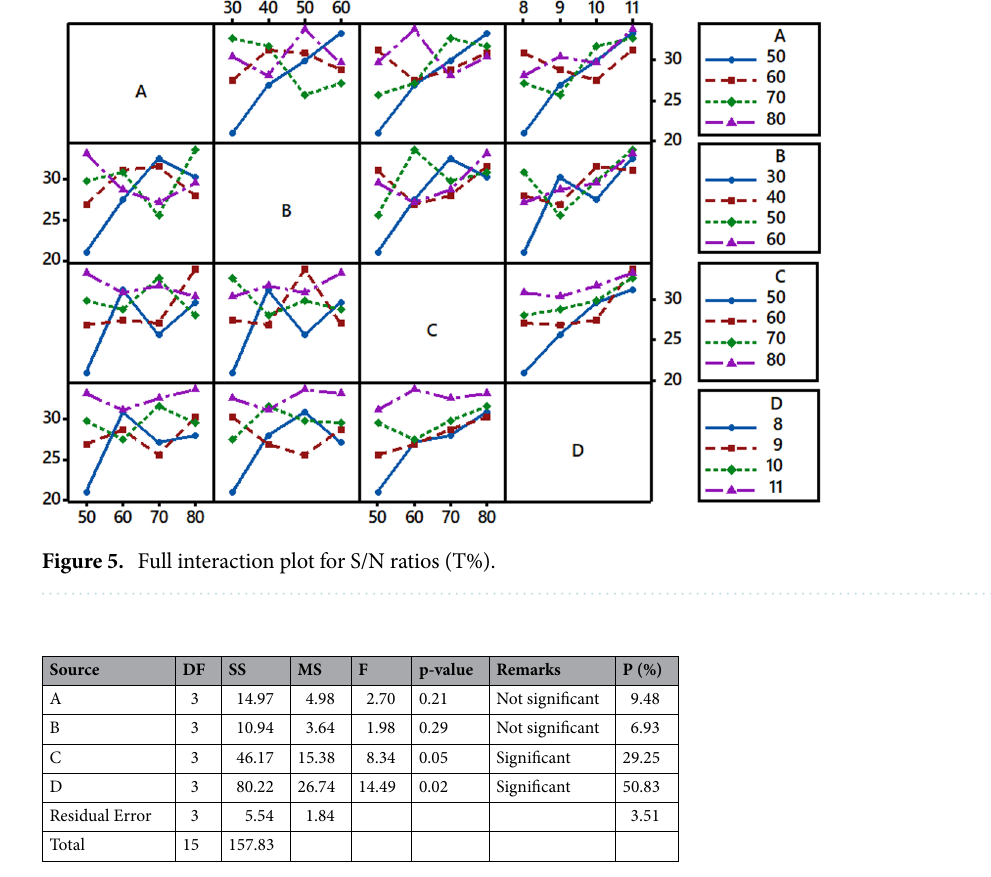
Table 9. ANOVA for S/N ratios of total dye fixation efficiency (T%).